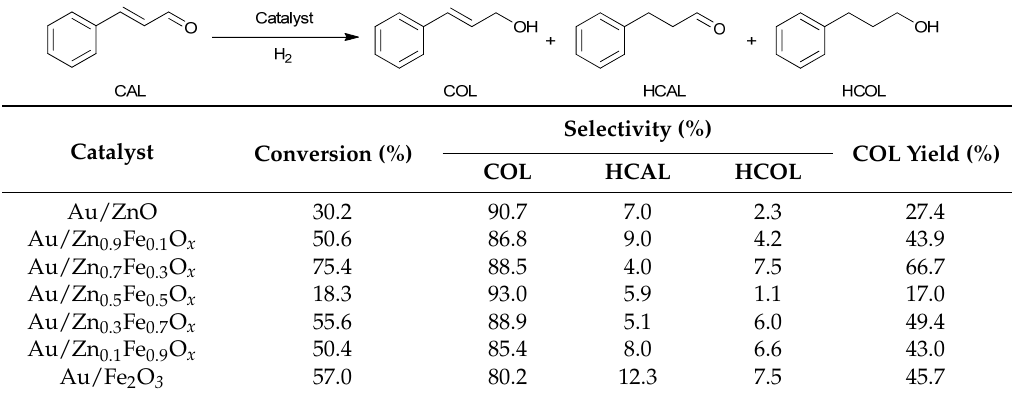
Table 4. Selective hydrogenation of cinnamaldehyde over the supported gold nanocatalysts.